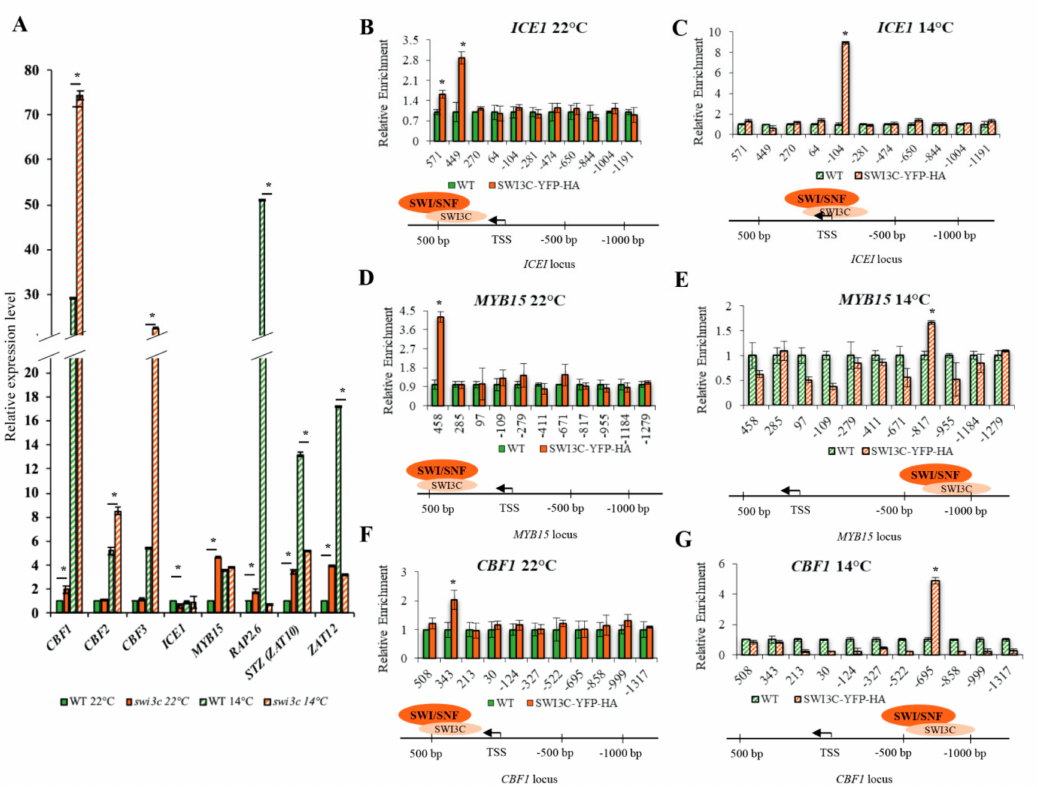
Figure 2. Altered Transcription of Genes Involved in Cold Signaling in the swi3c Mutant. ( A ) Relative expression levels of genes of cold signaling pathway in wild type and swi3c plants grown at 22 ◦ C and 14 ◦ C. Plants were in a developmental stage with 12 rosette leaves > 1mm length according to Boyes et al. (2001) [24]. Asterisks indicate significant di ff erence (*): p < 0.05 according to t-test. ( B ) SWI3C binding to 5 (cid:48) -UTR region of ICE1 at 22 ◦ C and ( C ) at 14 ◦ C. ( D ) SWI3C binding to the promoter region of MYB15 at 22 ◦ C and ( E ) at 14 ◦ C. ( F ) Peak position of SWI3C in the CBF1 promoter at 22 ◦ C and ( G ) at 14 ◦ C. The TA3 transposon served as reference gene. Three biological and three technical replicates were used. Plants were in the principal stage with 12 rosette leaves > 1mm length according to Boyes et al. (2001) [24]. Asterisks indicate significant di ff erence from wild type (*): p < 0.05 according to t-test. Bars refer to